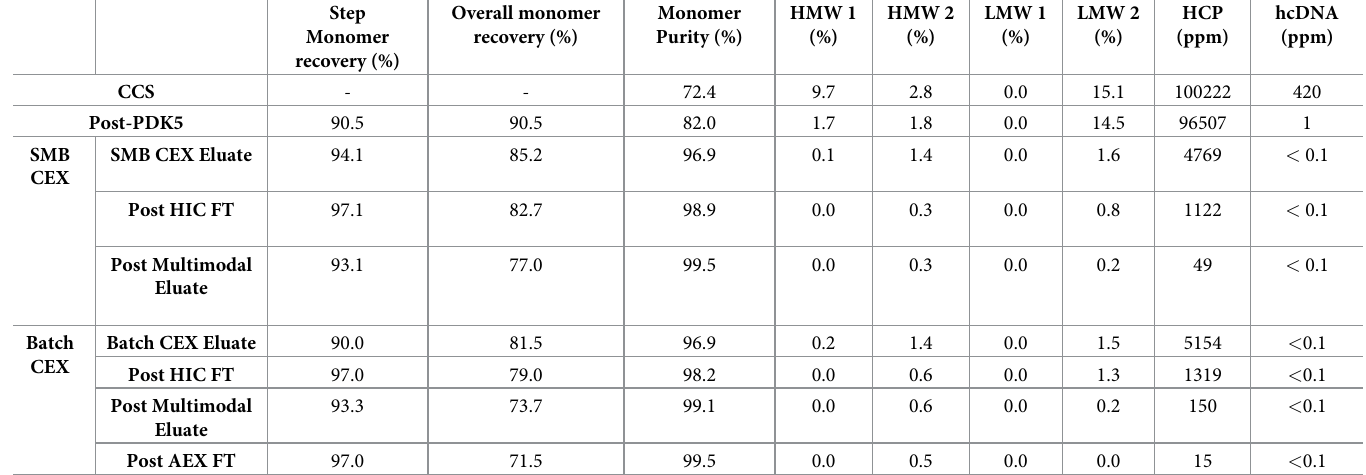
Table 4. Head to head comparison of the full purification process utilizing the SMB and batch CEX operations. All CEX runs were performed with a total of 4 mL resin and all polishing steps with 1 mL